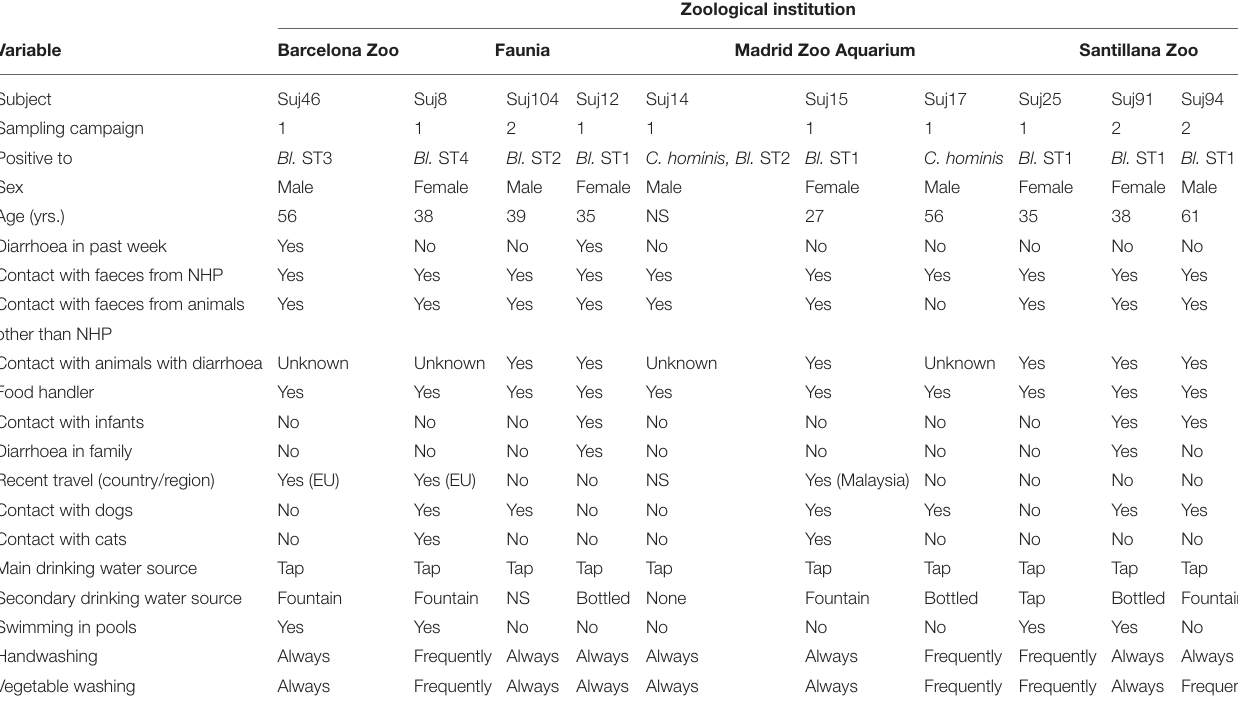
TABLE 5 | Sociodemographic, behavioural, and work-related factors potentially associated with protist zoonotic transmission in zookeepers in the present